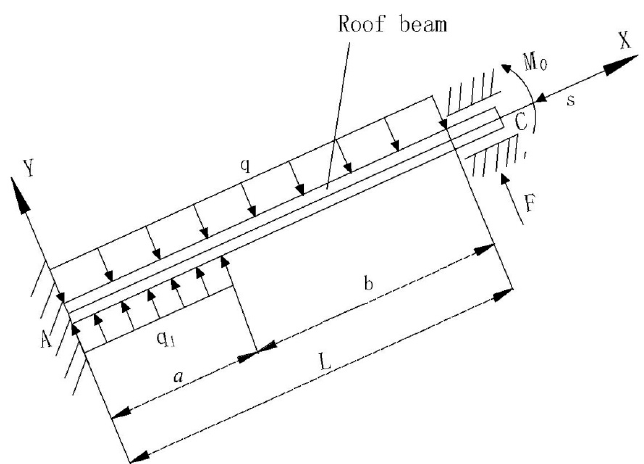
Figure 1. Schematic diagram of composited backfilling longwall mining in steeply dipping coal seam (SDCS).